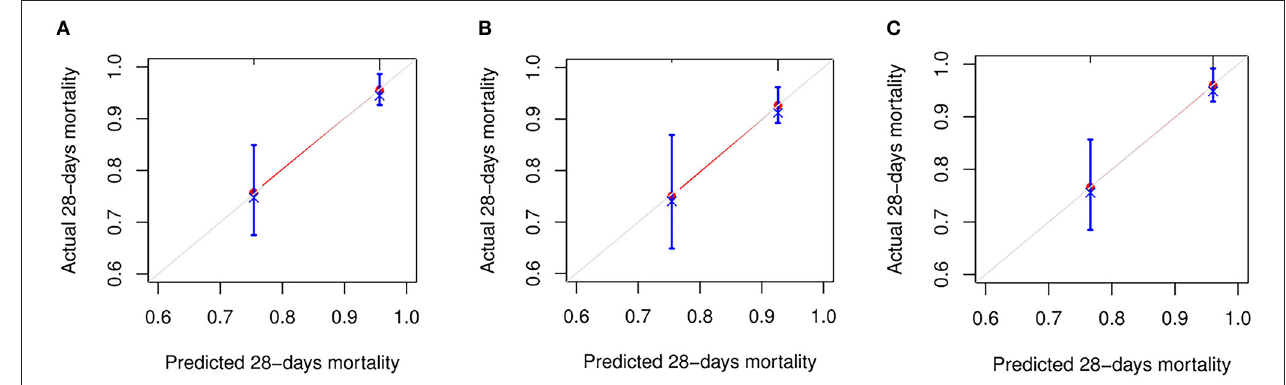
FIGURE 3 | The calibration curve for predicting the mortality at 28-days. (A) FIB-4; (B) APRI; and (C) NFS. FIB-4, Fibrosis-4; APRI, Aspartate Aminotransferase -to-platelet ratio index; NFS, NAFLD fibrosis